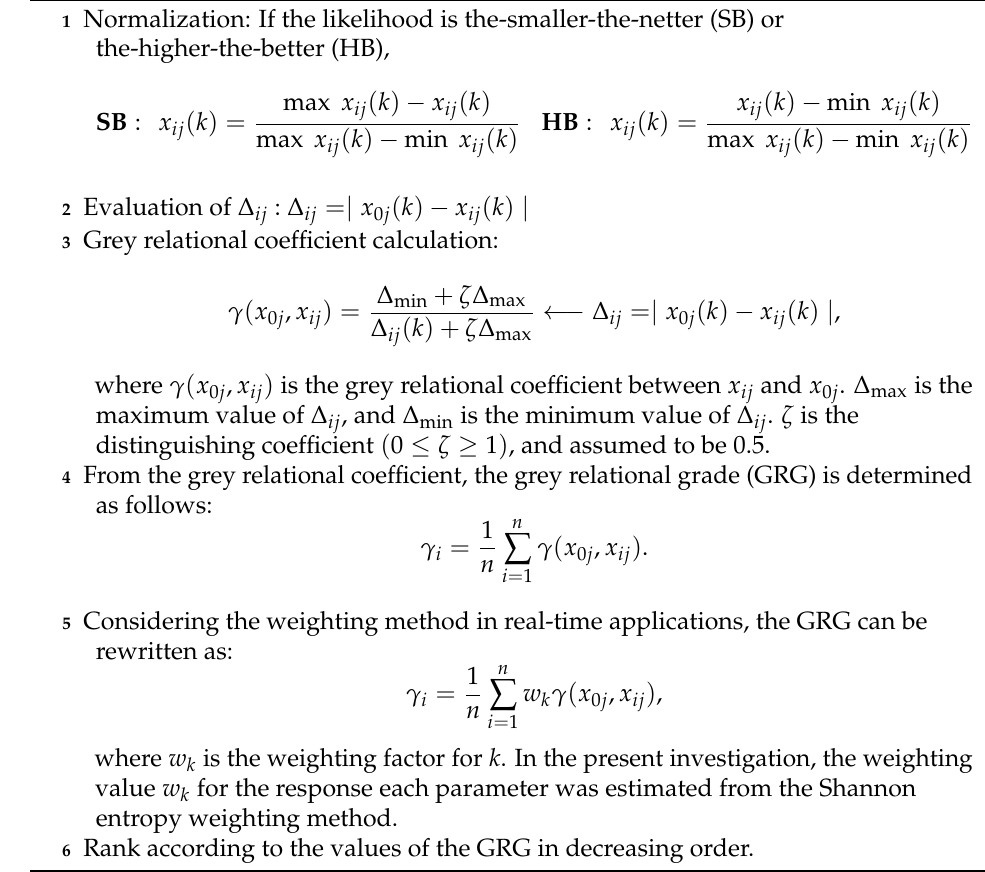
Algorithm 1: Procedures used for grey relational analysis (GRA)